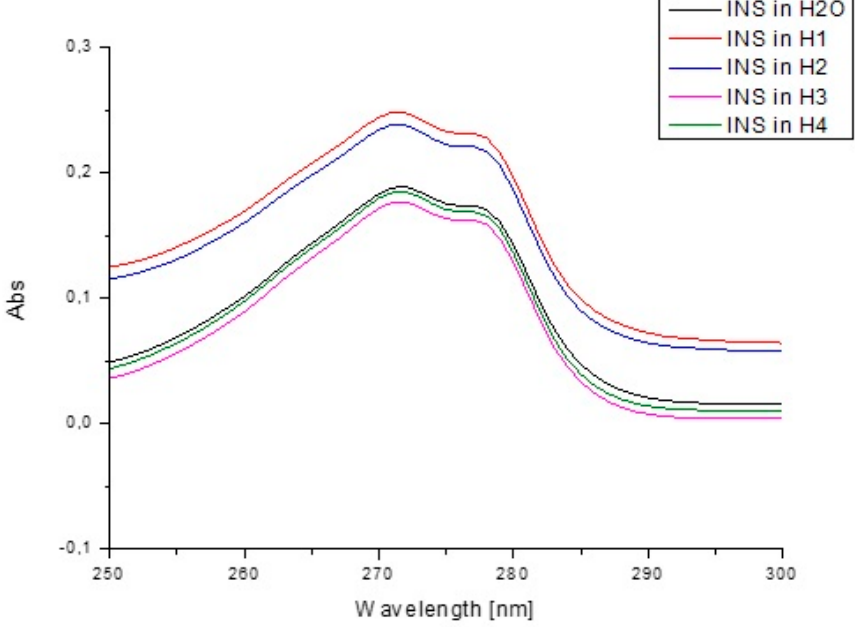
Figure 11. Absorption spectra of insulin at 1.04 × 10 − 5 g/cm 3 concentration both in H 2 O and in the presence of model hydrogels H1-H4.